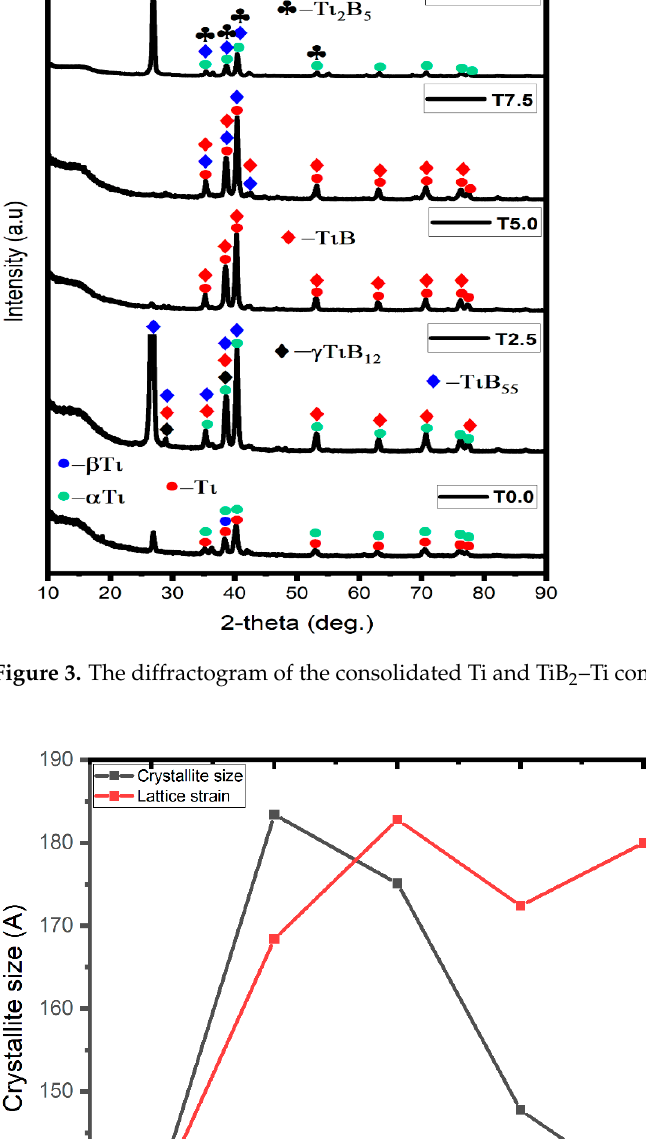
Figure 4. Values of the crystallite size and lattice strain of the consolidated Ti and Ti-TiB 2 composites.